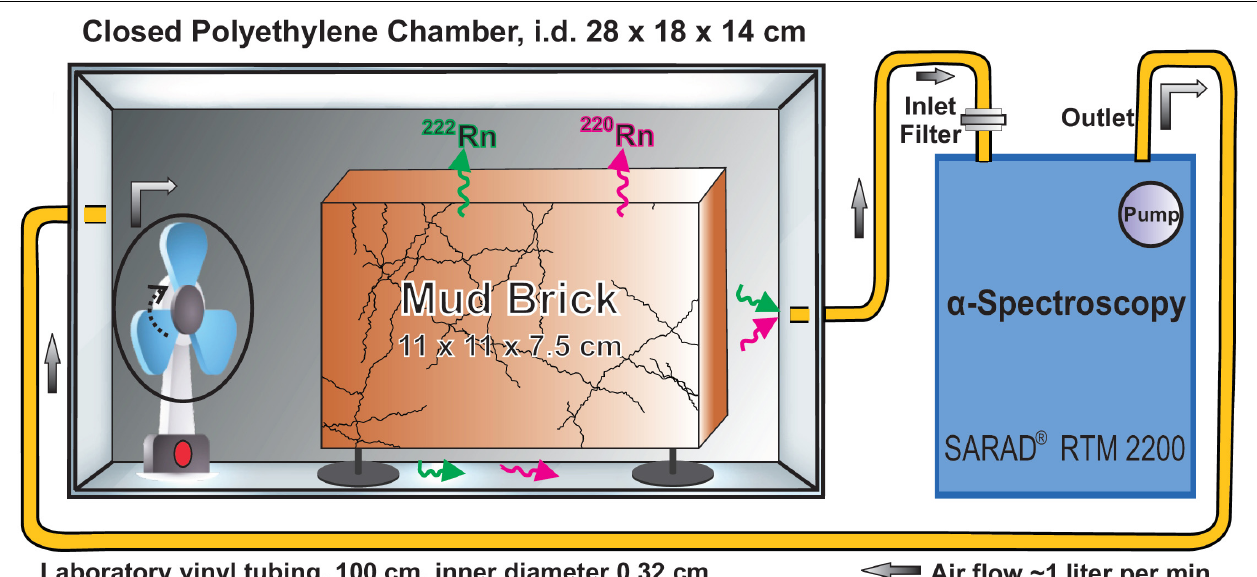
FIGURE 2 | Schematic for the reproducible measurement of 220 Rn exhalation rates from mud bricks. A mud brick is placed into a high-density polyethylene chamber exposing all brick surfaces to turbulent air. Air from the chamber rapidly circulates through tubing and an α -spectrometer. Image of fan courtesy of